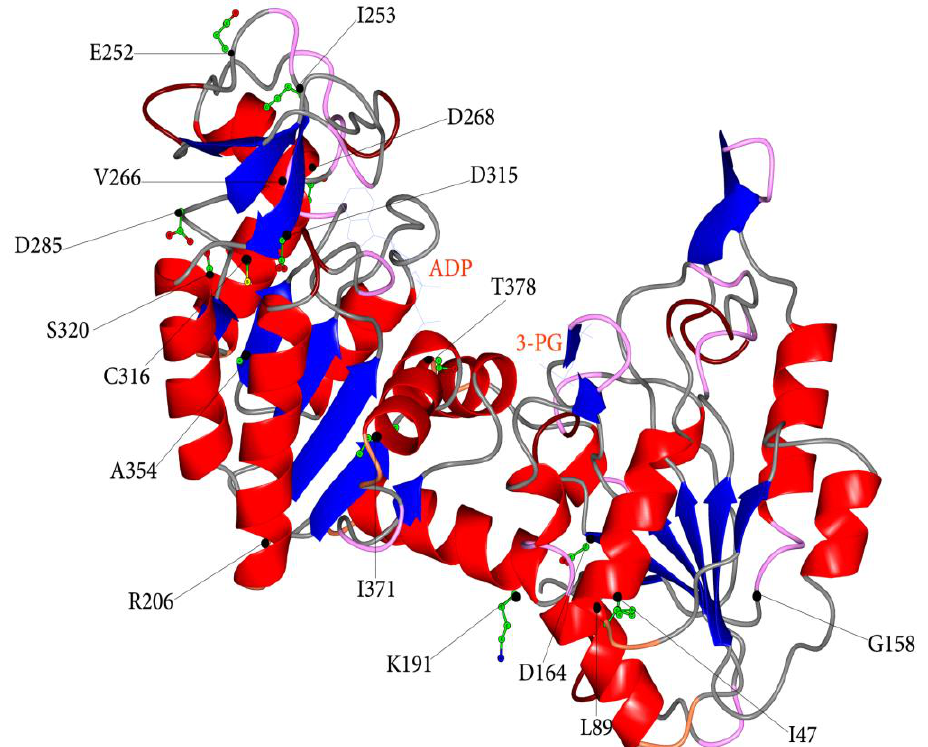
Figure 2. Ribbons representation of human PGK1 in open conformation (PDB ID, 2XE7). The bound ligands are shown as stick model. The side chains of amino acids affected by mutations are indicated by black spheres and represented as ball and